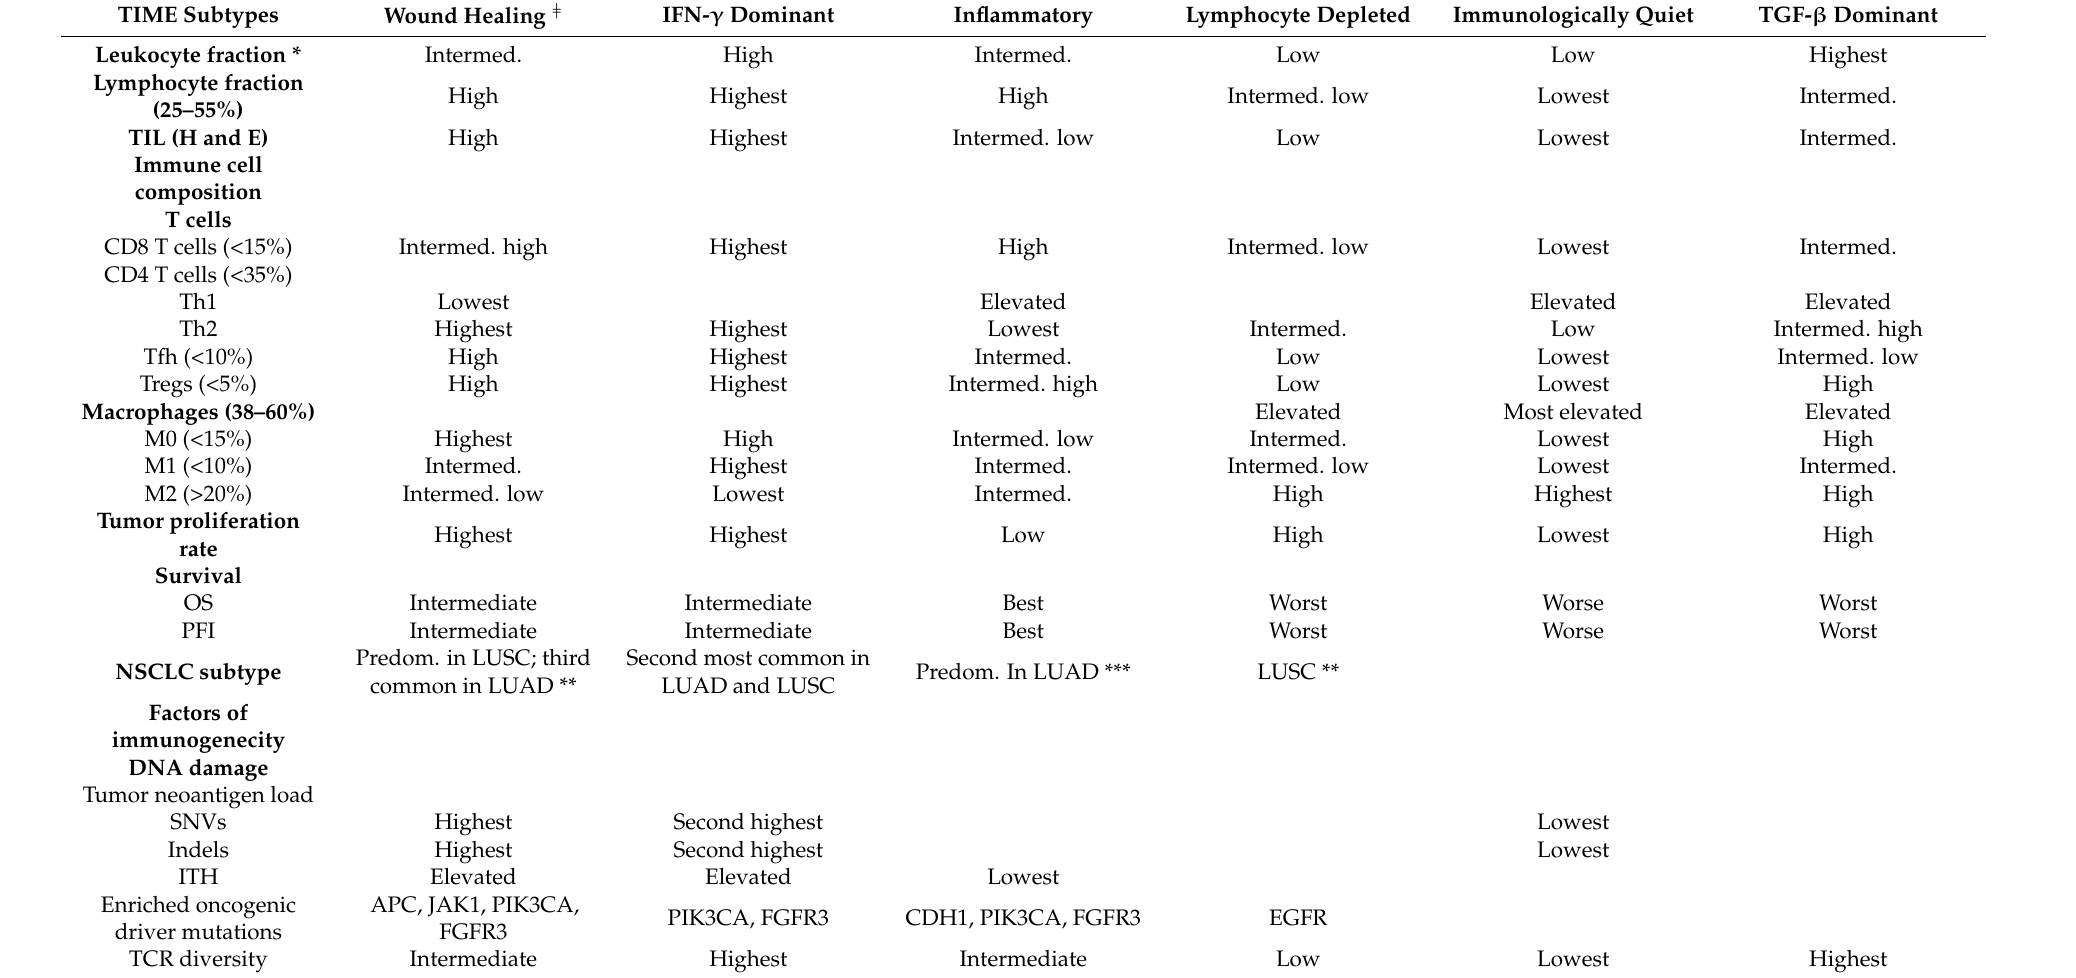
Table 2. Characteristics the TCGA TIME subtype